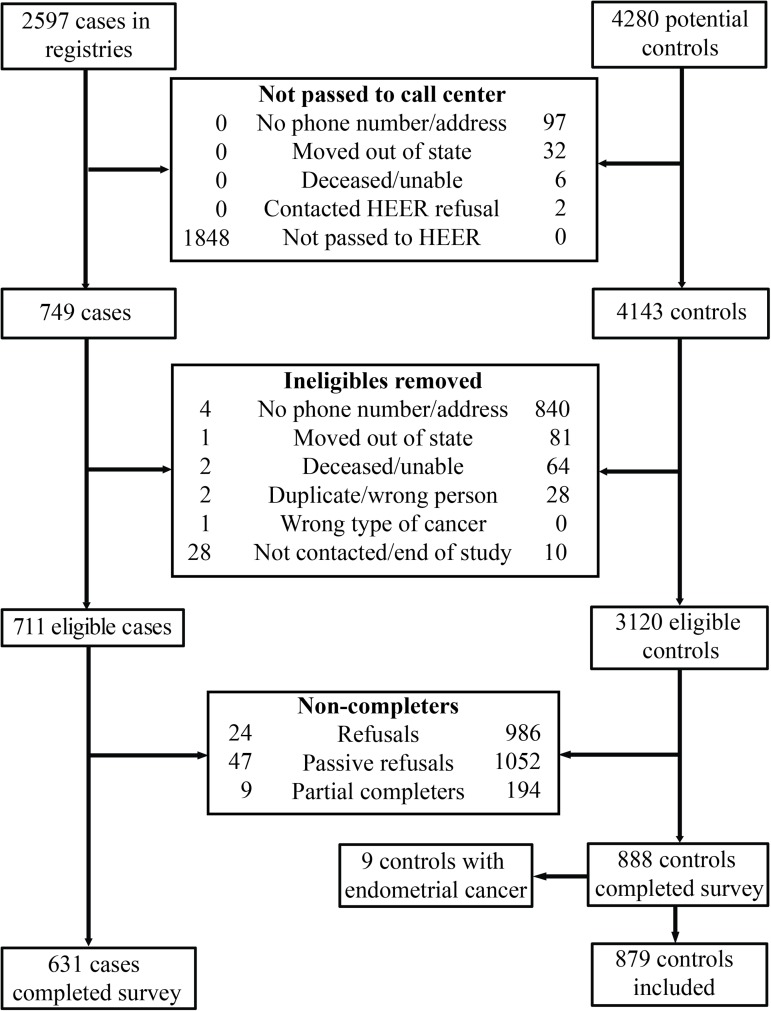
Exclusion and enrollment of participants in the Health and Environmental Exposure Research study.